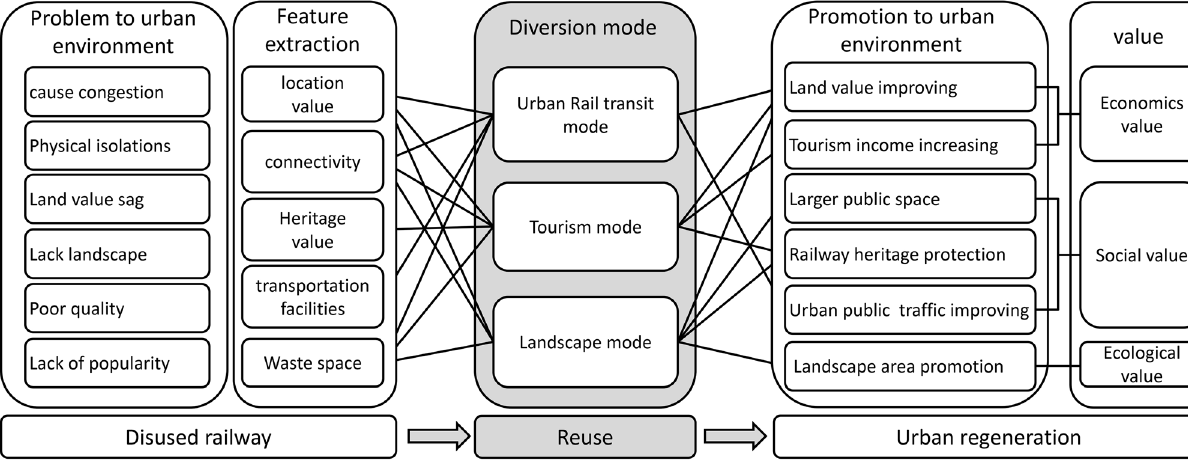
Fig. 2 The research framework of rail transportation leading to urban regeneration. Source : Drawn by the